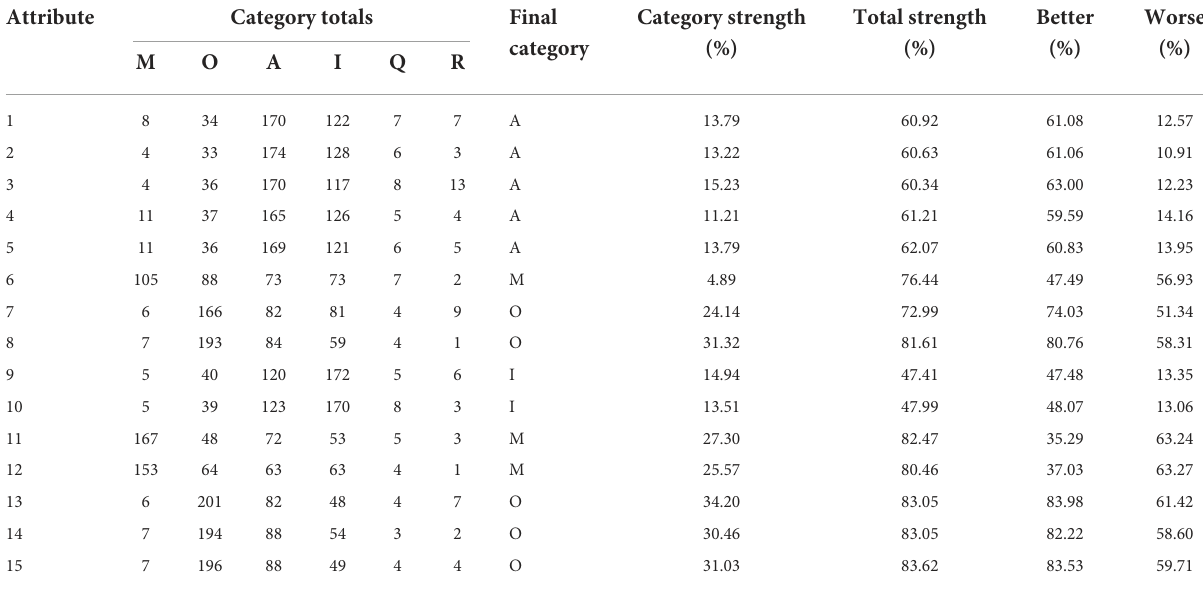
TABLE 4 Evaluation of the attributes of telenursing needs using Kano